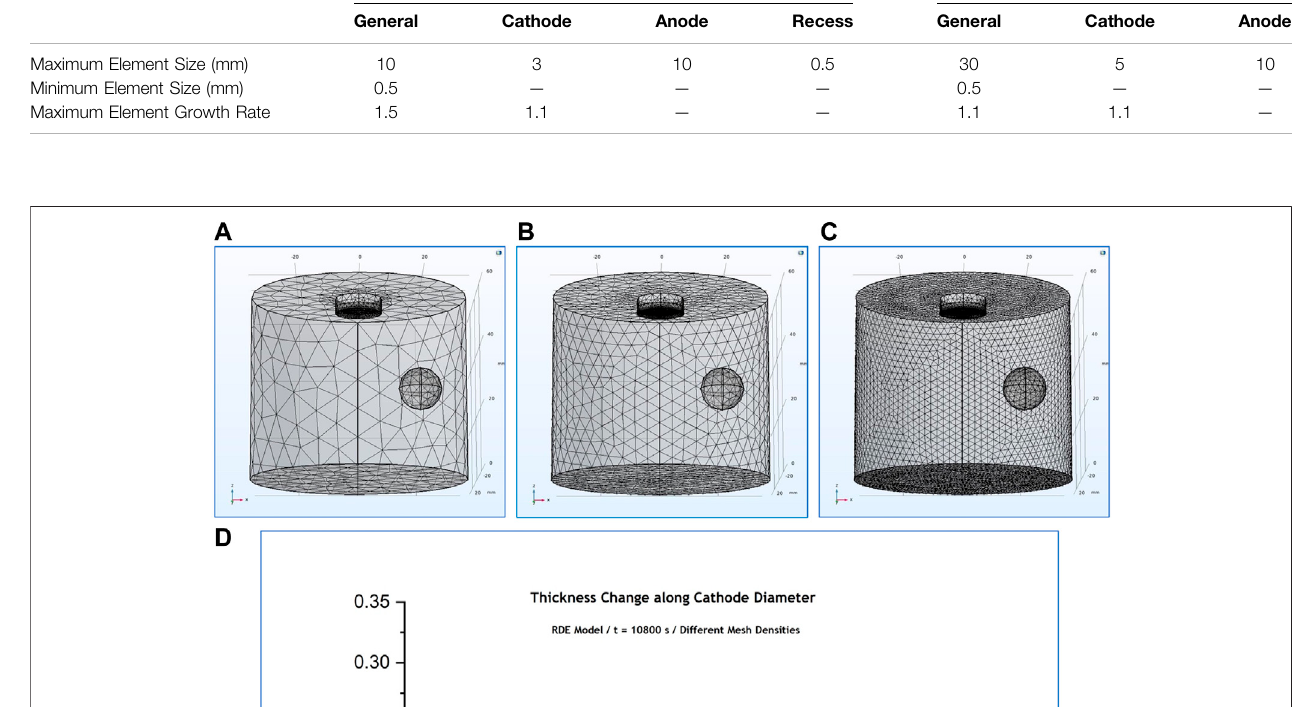
TABLE 2 | User-de fi ned, general and boundary element size parameters for both the RDE and scaled- up models. Element Size Parameters